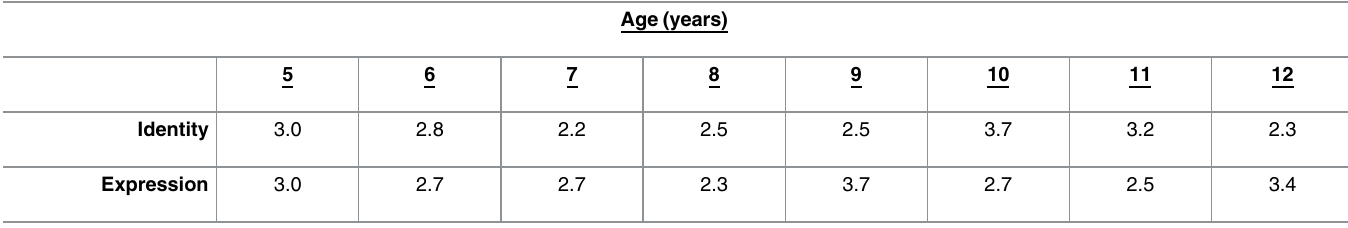
Table 2. Percentage of trials removedfor each task by